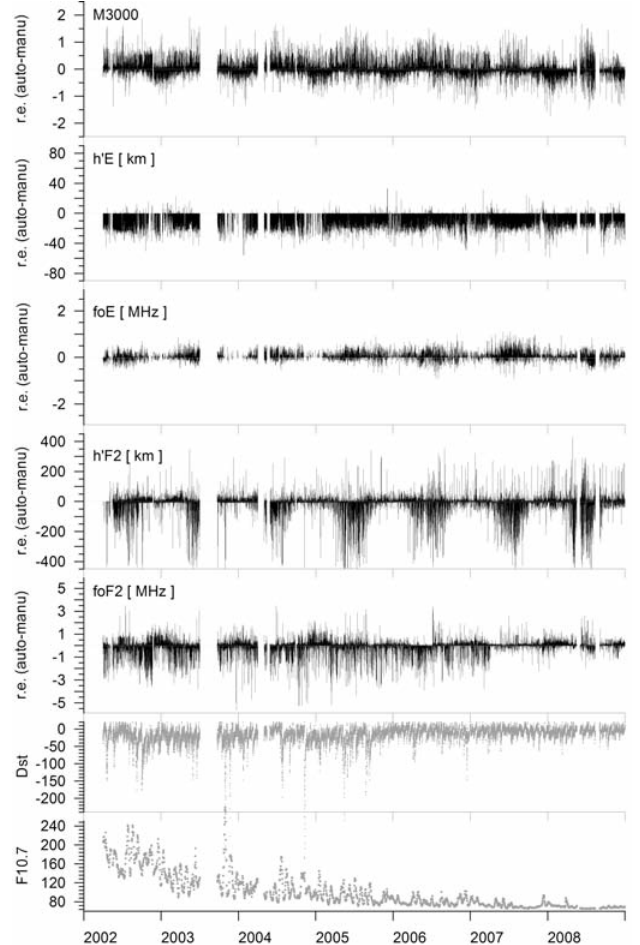
Figure 4. Residual errors (automatically [auto] minus manually [manu] scaled values) for different ionospheric characteristics during the period of 2002 to 2008. The solar and geomagnetic activity indices, Dst [nT] and F10.7 [10-22Wm-2Hz-1], are plotted in the bottom